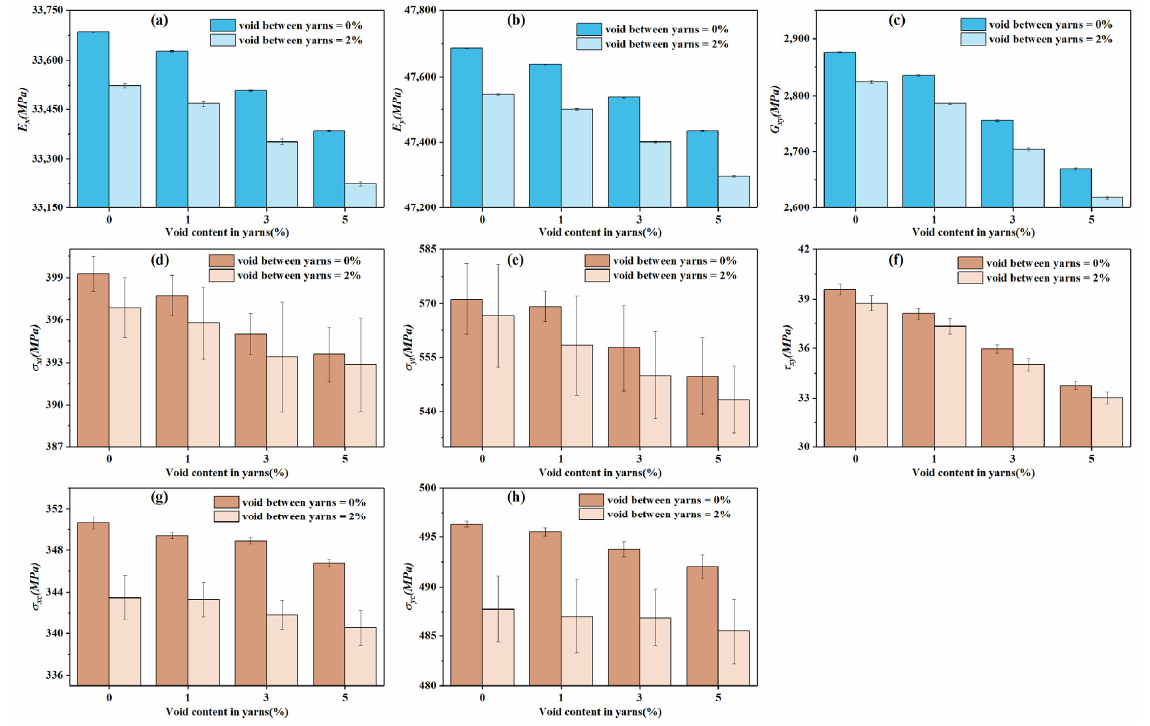
Figure 15. Statistical elastic properties and strength properties of mesoscale model in warp, weft and in-plane shear directions. ( a – c ) represent the elastic moduli of 3DOWCs; ( d – h ) represent the strength properties of 3DOWCs.